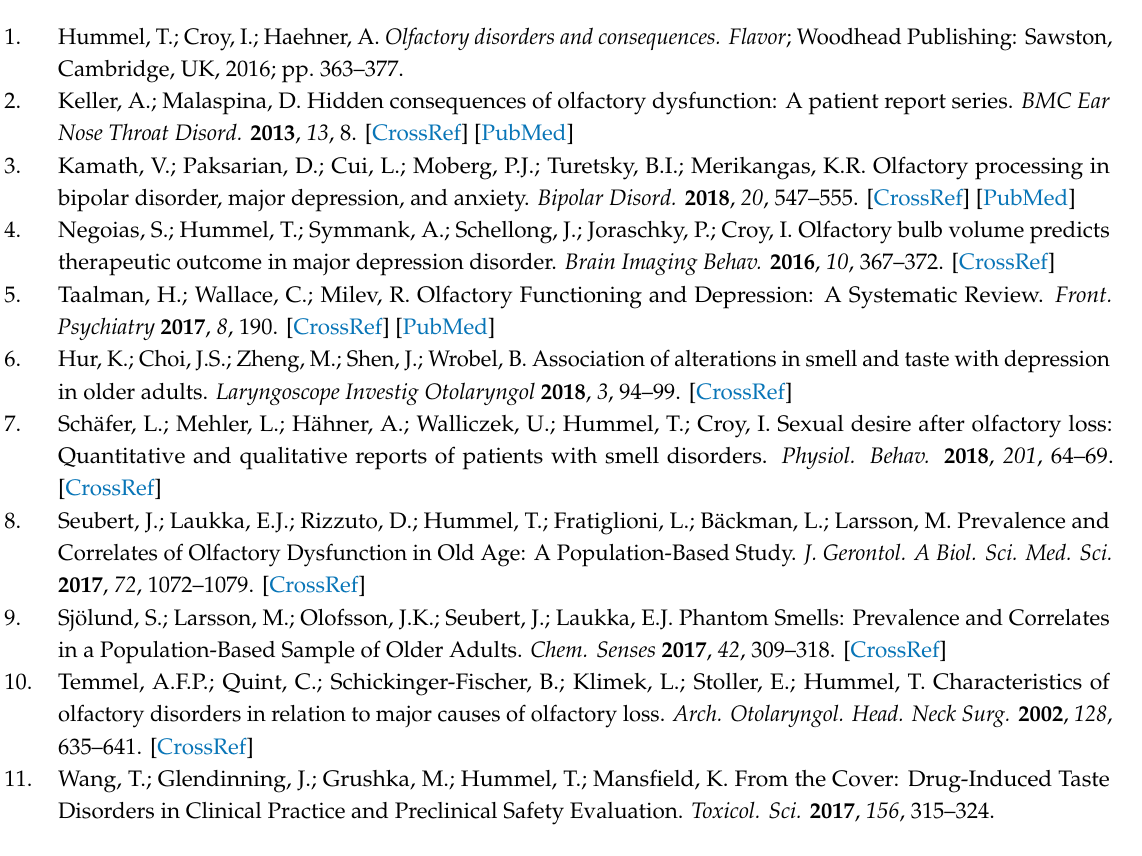
Figure S1: Directed acyclic graphs (DAGs) for selecting minimized sets of variables of the crude-adjusted models (A) and the fully-adjusted models